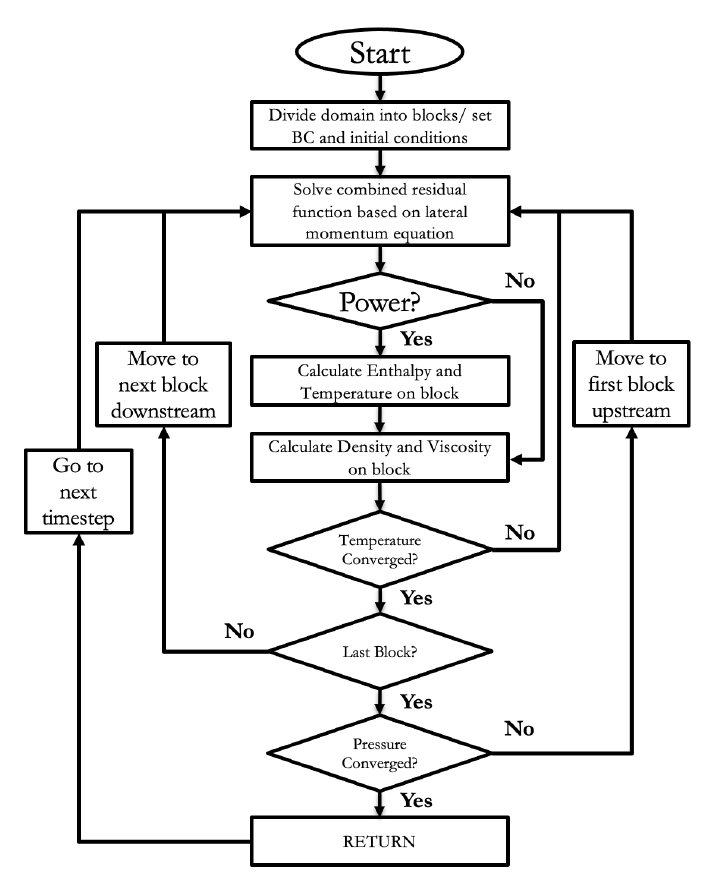
Figure 3. Subchannel hybrid numerical